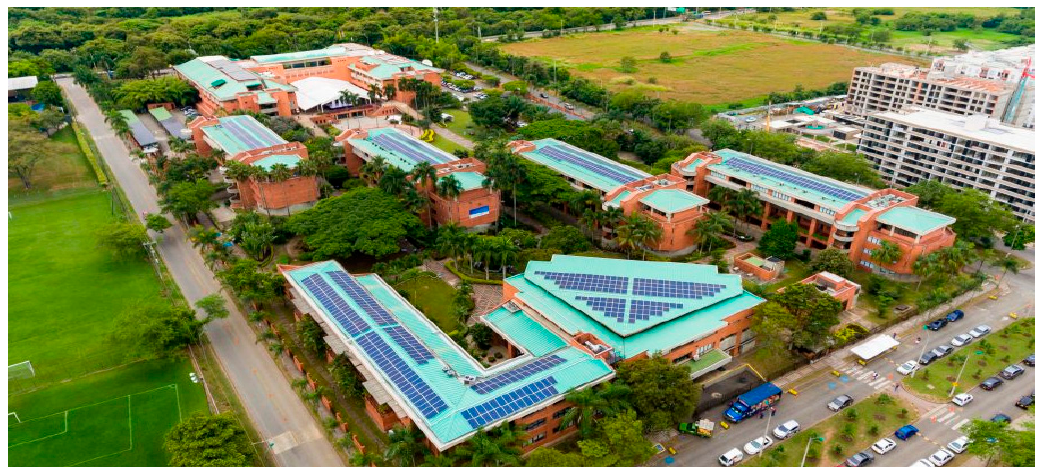
Figure 1. University Campus of the Autónoma of Occidente University (Cali, Colombia).